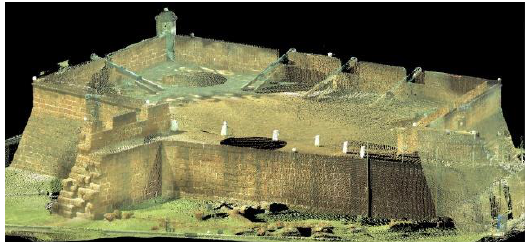
Figure 3. The coloured point cloud data of the Bastion Middleburg monument